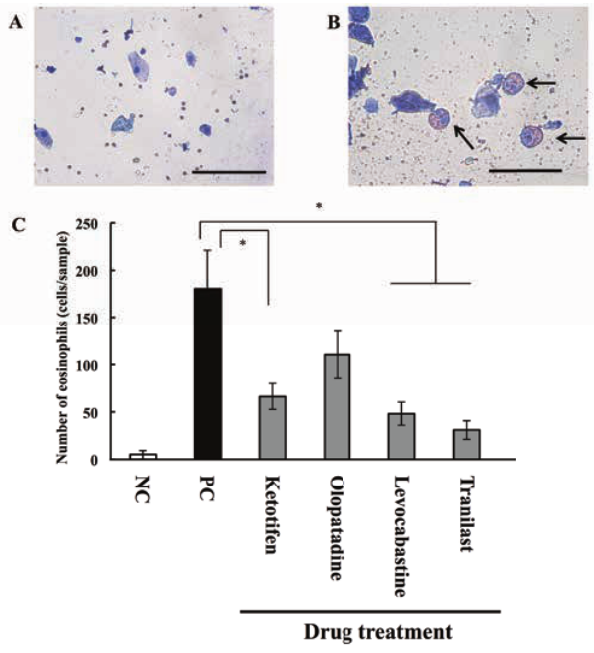
Figure 4: Effects of anti-allergic drugs on eosinophils in conjunctiva. Guinea pigs were sensitized by injecting OA and aluminum hydro- xide gel into the conjunctival sac. AC was elicited by the instillation of OA solution on days 15, 17, and 19. At 4 h after the final challenge (i.e., day 19), eosinophils were collected from the palpebral conjunc- tival epithelial tissue. Samples from the (A) negative and (B) positive control groups were stained using Giemsa’s solution (scale bars, 50 μm). (C) The number of eosinophils in conjunctival epithelial tissues from AC animals with or without eye drop drug treatment. * P < 0.05 vs. positive control group. Data represent means ± S.E.M from three independent experiments (n = 9 in the negative control group; and n = 12 in the positive control and drug treatment